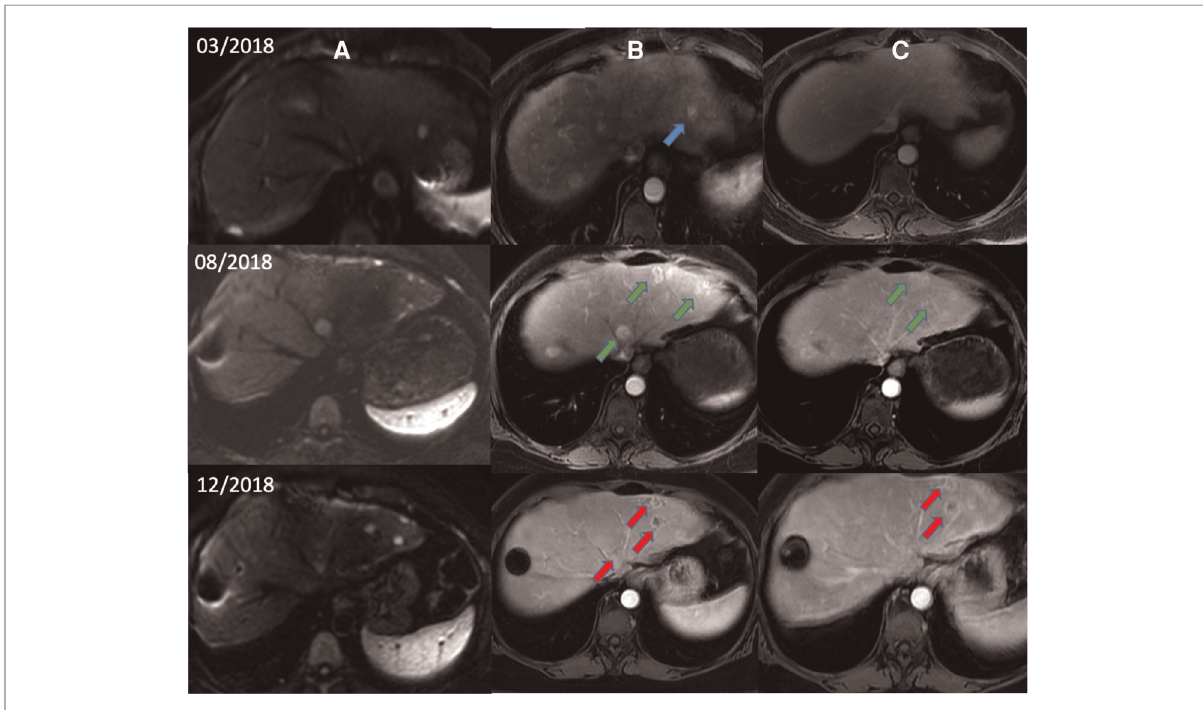
FIGURE 2 Magnetic resonance images from a patient with HCC after low-power amplitude-modulated radiofrequency electromagnetic fi eld exposure. Diffusion-weighted imaging ( A ), arterial phase ( B ), and delayed phase ( C ) are shown. Patient with advanced HCC began treatment with sorafenib in March 2018 after diagnosis of recurrent HCC by diffusion and arterial phases (blue arrows). After documented radiological progression in August 2018 (green arrows), sorafenib was suspended and AutEMdev was started in 2-week intervals. In December 2018, lytic changes in the tumour lesions were observed by the arterial and delayed phases (red arrows). The patient was submitted to a surgical procedure to